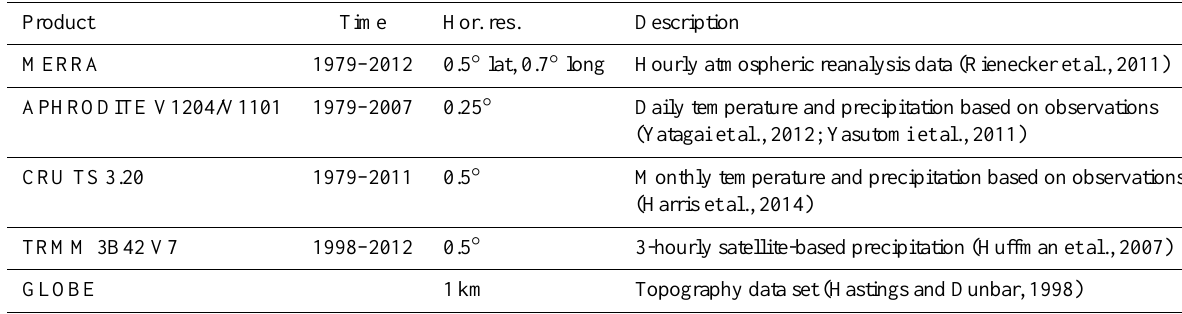
Table 1. Combinations of data types used in snowfall estimates: T is temperature and P is precipitation. f (P, T ) indicates that snowfall is calculated as a function of P and T . Precipitation Temperature Snowfall Time MERRA MERRA Present MERRA reference MERRA Terrain-adjusted MERRA f (P, T ) Present MERRA T2m MERRA MERRA T2m f (P, T ) Present Bias-corrected with obs. T MERRA Bias-corr. terrain-adj. MERRA f (P, T ) Present Bias-corrected with obs. P Bias-corr. MERRA Terrain-adjusted MERRA f (P, T ) Present Bias-corrected with obs. T , P Bias-corr. MERRA Bias-corr. terrain-adj. MERRA f (P, T ) Present CMIP5 T MERRA Terrain-adj. MERRA + (cid:49)T CMIP5 P MERRA · (cid:49)P Terrain-adj. MERRA CMIP5 T , P MERRA · (cid:49)P Terrain-adj. MERRA + (cid:49)T Bias-corr. CMIP5 T Bias-corr. MERRA Bias-corr. terrain-adj. MERRA + (cid:49)T Bias-corr. CMIP5 P Bias-corr. MERRA · (cid:49)P Bias-corr. terrain-adj. MERRA Bias-corr. CMIP5 T , P Table 2. Data sets used in calculations of present-day snowfall. Product Time Hor. res.